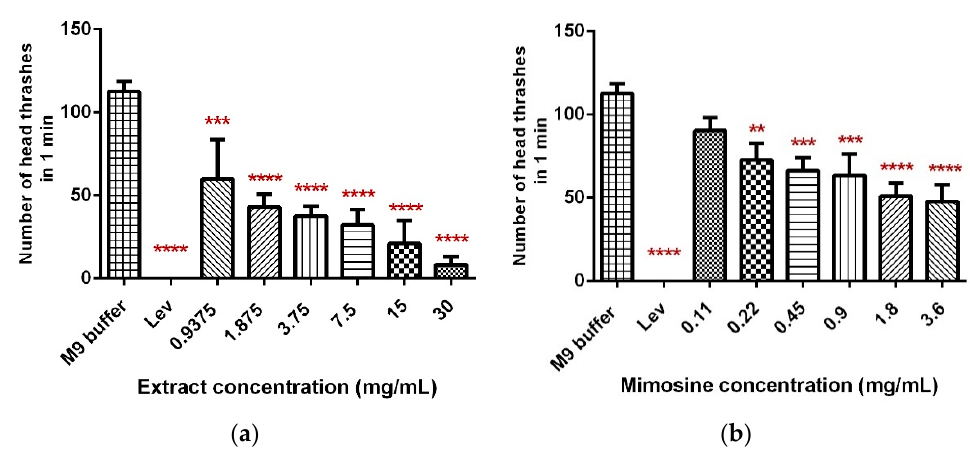
Figure 6. Effect of LL extract and mimosine on head thrashing activity in C. elegans . ( a ) The number of head thrashes per min in LL extract. ( b ) The number of head thrashes per min in mimosine. Data are presented as means ± SD and are compared to M9 buffer as the negative control. Statistical significance was calculated using a one-way ANOVA with Dunnett’s multiple comparison test and is denoted by asterisks. ** p ≤ 0.01; *** p ≤ 0.001; **** p ≤ 0.0001. n = 15 worms. Table 4. Head thrashing activity of LL extract and mimosine.